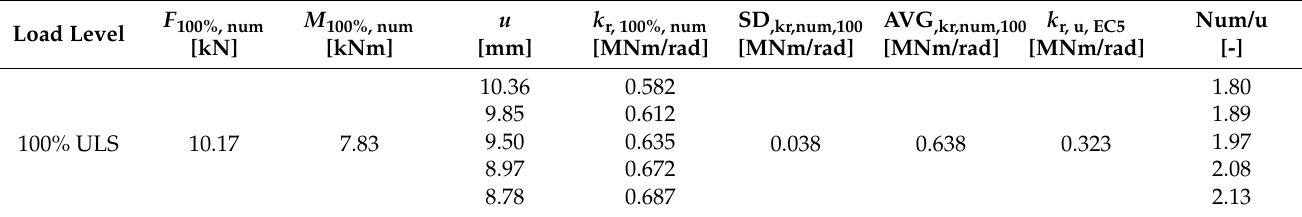
Table 17. Results of quasi-static cyclic numerical modeling for Experiment B at 100%